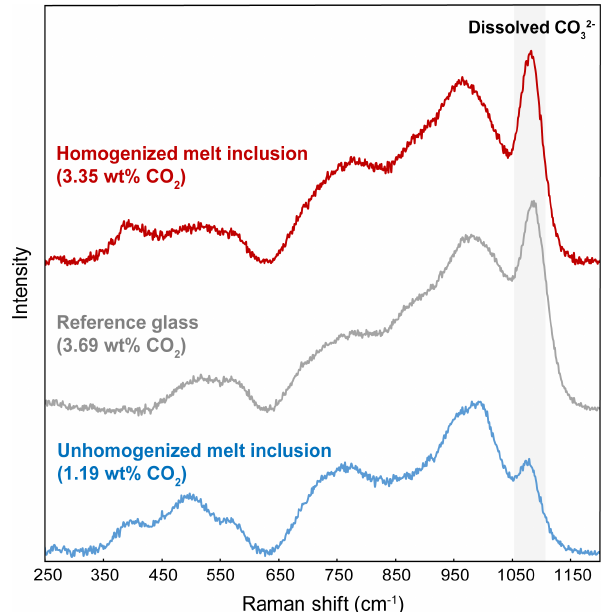
Figure 8. Comparison of the Raman spectrum of basanitic standard BSN150121 (3.69wt% CO 2 ) in grey with a spectrum representa- tive of an unheated melt inclusion (Thu3-6a) in blue and a spectrum after homogenization at 2.5GPa–1300 ◦ C (HOP no. 5a-MI) in red. The size of the CO 2 − band at 1080cm − 1 in the glass homogenized 3 at 2.5GPa is as big as the CO 2 − band in the basanitic standard with 3 3.69wt% CO 2